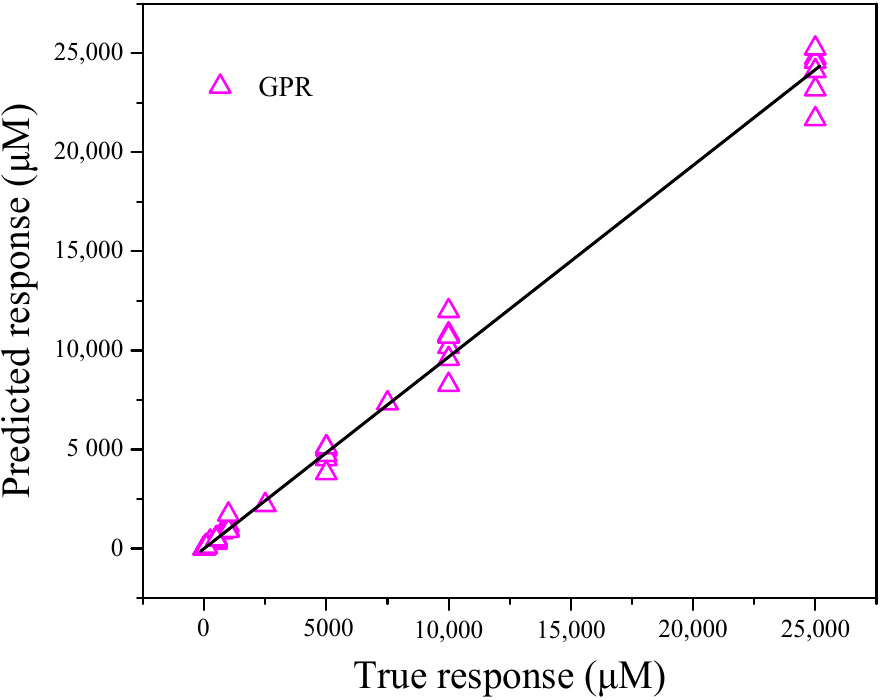
Figure 13. Predicted Ca 2+ concentrations obtained by the established GPR model vs. the actual Ca 2+